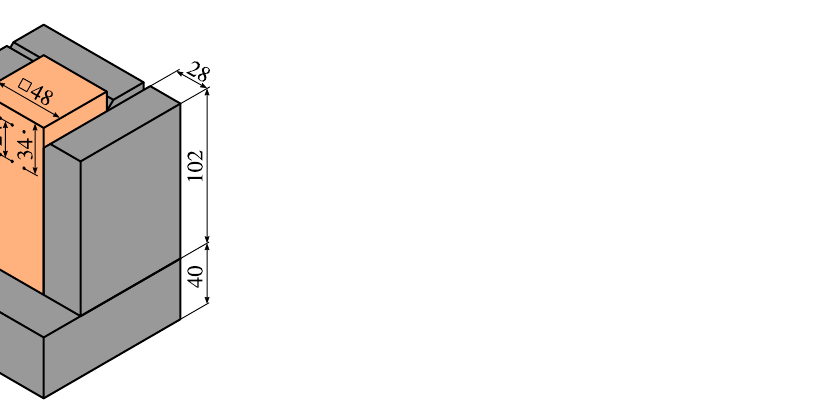
Figure 3. Dimensions of the heated block, dimensions of the insulation and the distance between lines of TCs and the heating